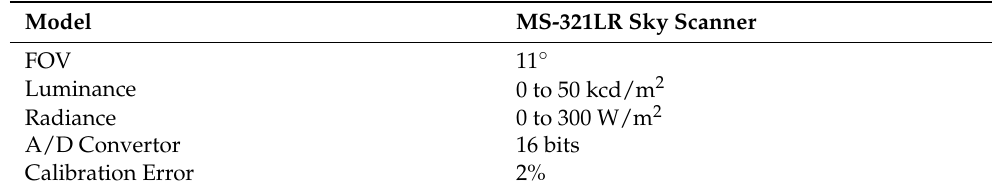
Table 4. Sky scanner technical specifications.